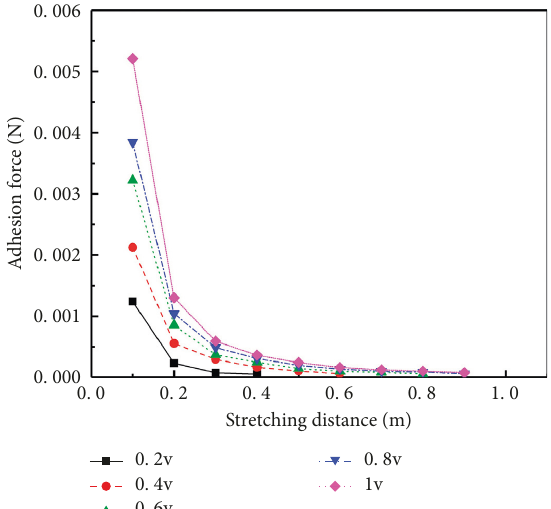
Figure 14: Variation curve of adhesion force with stretching distance under 40 ° contact angle and different liquid volume.